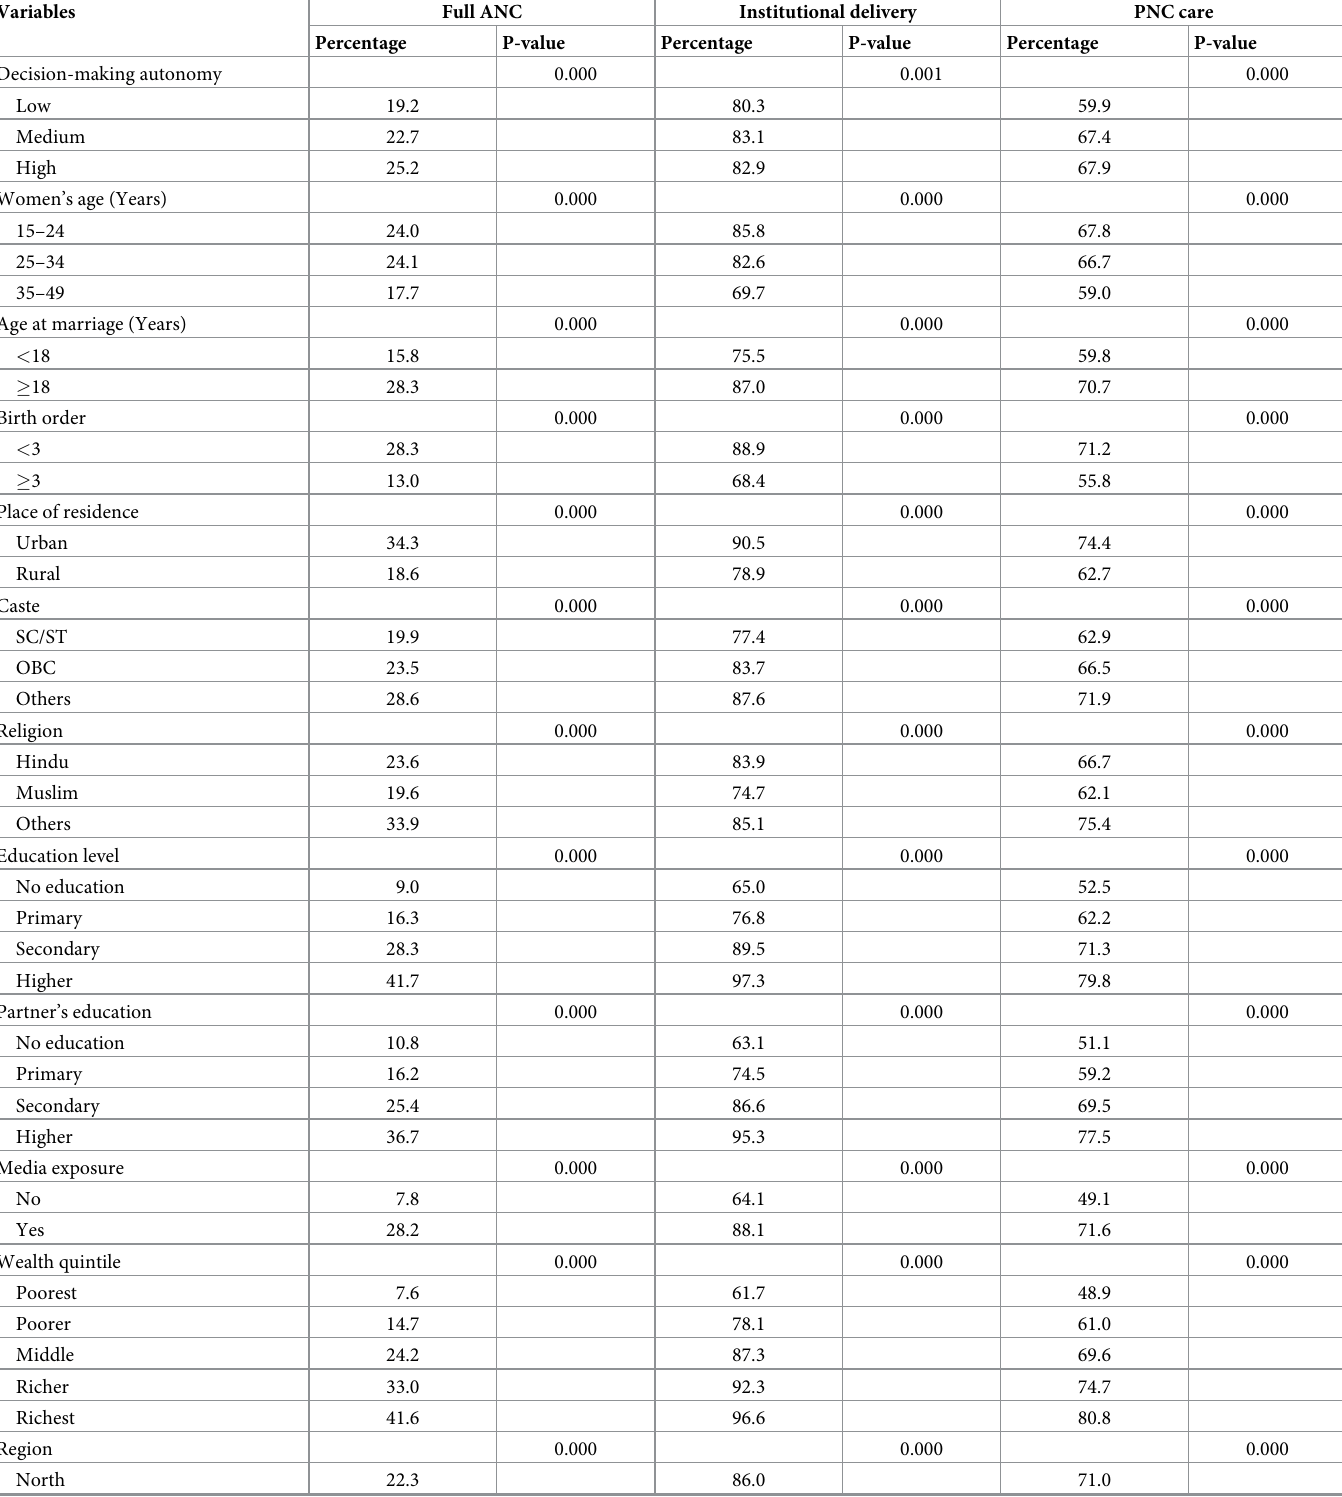
Table 2. Distribution of maternal healthcare services by the socio-demographic